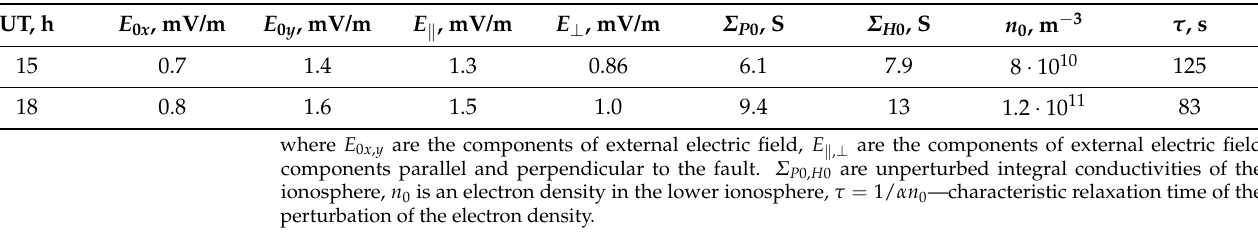
Figure 3. An example of the spatial distribution of the integrated Pedersen ( left panel) and Hall ( right panel) conductivities. The red vertical line shows the position of the subsolar meridian.